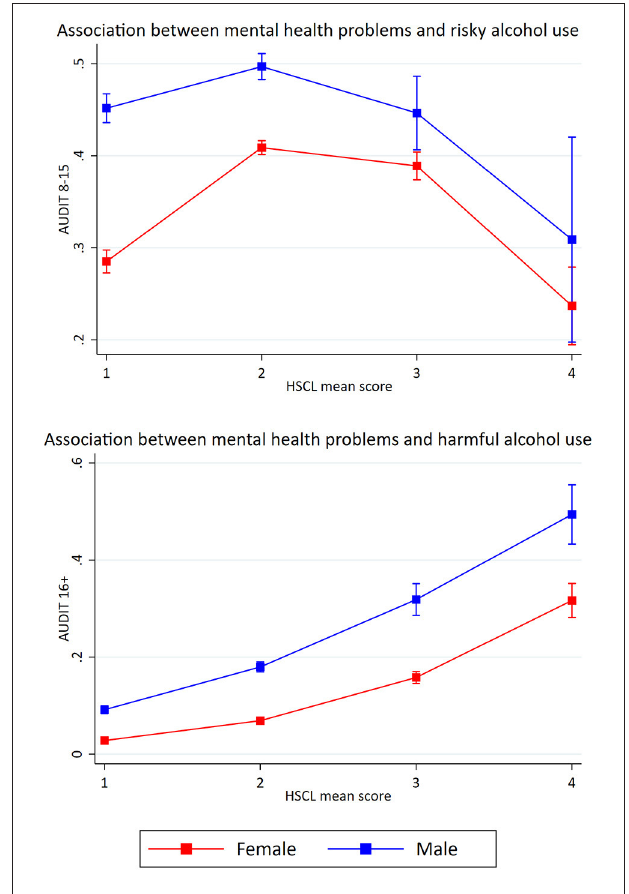
FIGURE 5 | Gender-specific associations between mental health problems and potential alcohol-related problems. Retained models. Predicted probabilities of alcohol-related problems (The Alcohol Use Disorders Identification test; AUDIT) across mean scores on Hopkins Symptom Checklist (HSCL). Error bars represent 95% confidence